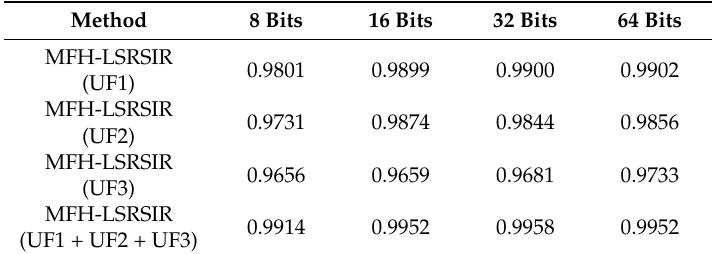
Table 2. MAP scores of the SAT-4 dataset.